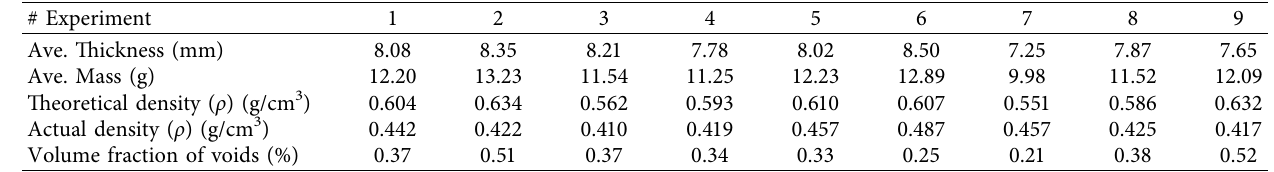
Figure 8: Main effect plot for the SN ratio for modulus of elasticity (MOE). Table 10: Actual and theoretical densities of the particleboard.